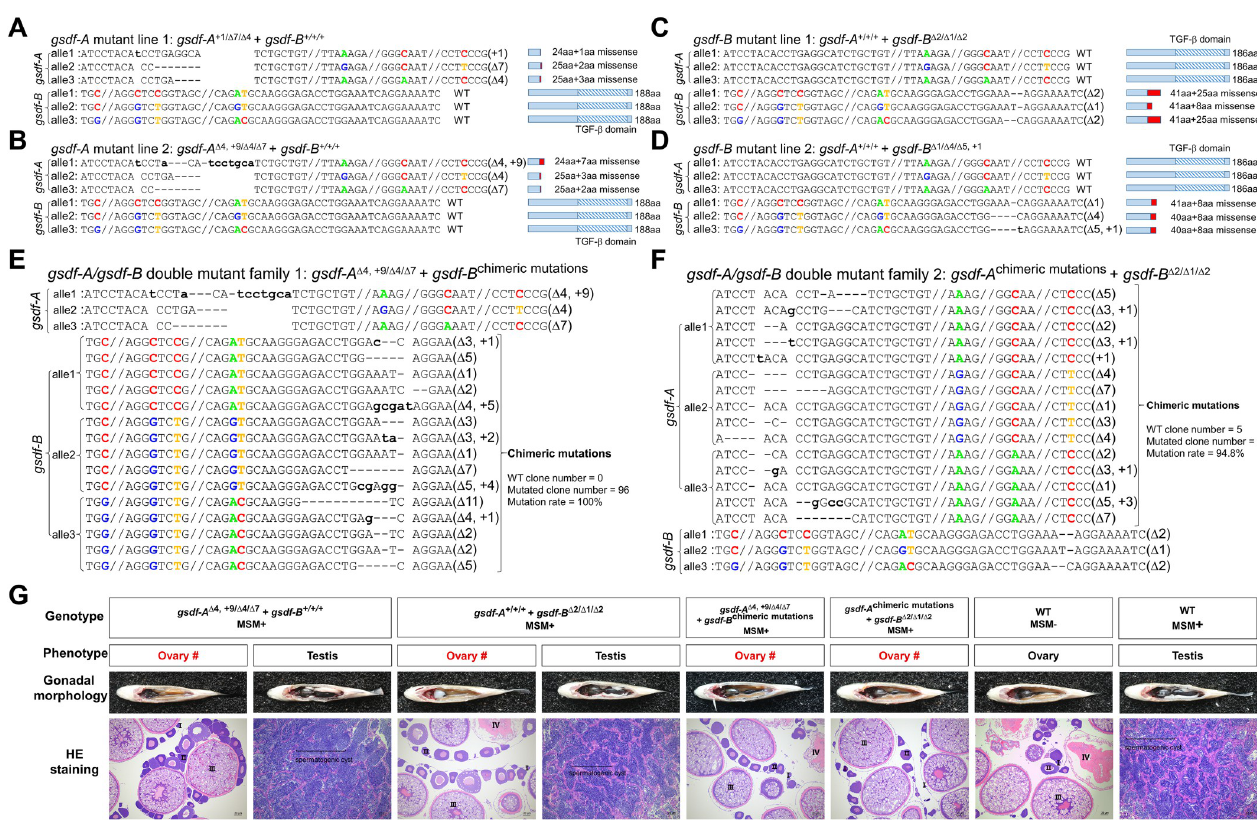
Fig 4. Genotypes and phenotypes of gsdf mutants. (A-F) Genotypes of gsdf mutants: gsdf-A mutant line 1 ( gsdf-A +1/ Δ 7/ Δ 4 + gsdf-B +/+/+ ) (A) , gsdf-A mutant line 2 ( gsdf-A Δ 4,+9/ Δ 4/ Δ 7 + gsdf-B +/+/+ ) (B) , gsdf-B mutant line 1 ( gsdf-A +/+/+ + gsdf-B Δ 2/ Δ 1/ Δ 2 ) (C) , gsdf-B mutant line 2 ( gsdf-A +/+/+ + gsdf-B Δ 1/ Δ 4/ Δ 5,+1 ) (D) , gsdf- A / gsdf-B double mutant family 1 ( gsdf-A Δ 4,+9/ Δ 4/ Δ 7 + gsdf-B chimeric mutations ) (E) , and gsdf-A / gsdf-B double mutant family 2 ( gsdf-A chimeric mutations + gsdf-B Δ 2/ Δ 1/ Δ 2 ) (F) . (G) Gonadal morphology and histology of adult gonads. #, sex reversal; I, primary oocyte; II, growth stage oocyte; III, vitellogenic oocyte; IV, maturing oocyte. Bars are shown at bottom-right of the images. MSM+, with MSM; MSM − , without MSM; WT, wild type.